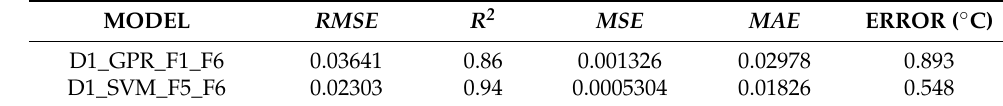
Table 8. D1 performance metrics on empirical data.